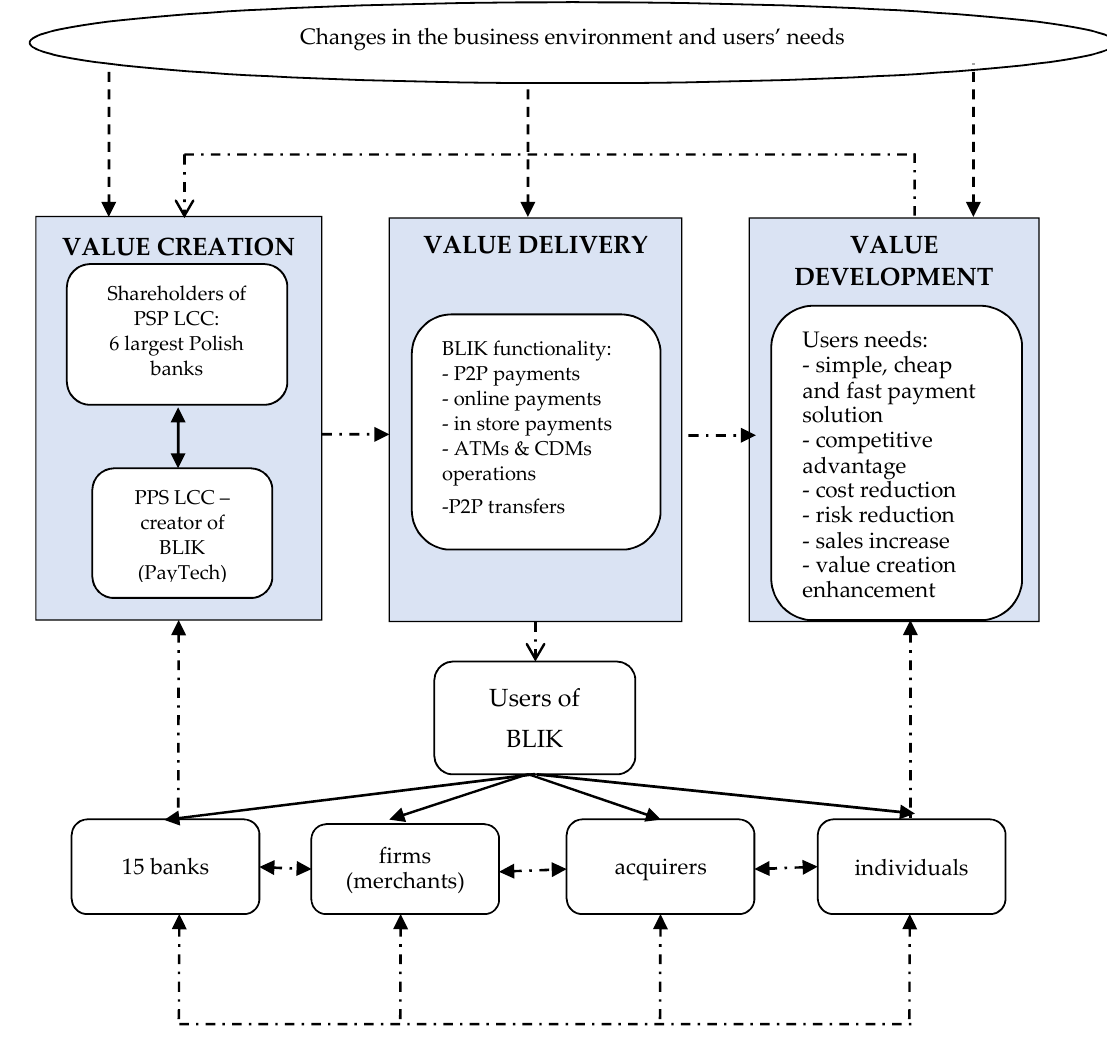
Figure 5. BLIK open business model architecture.